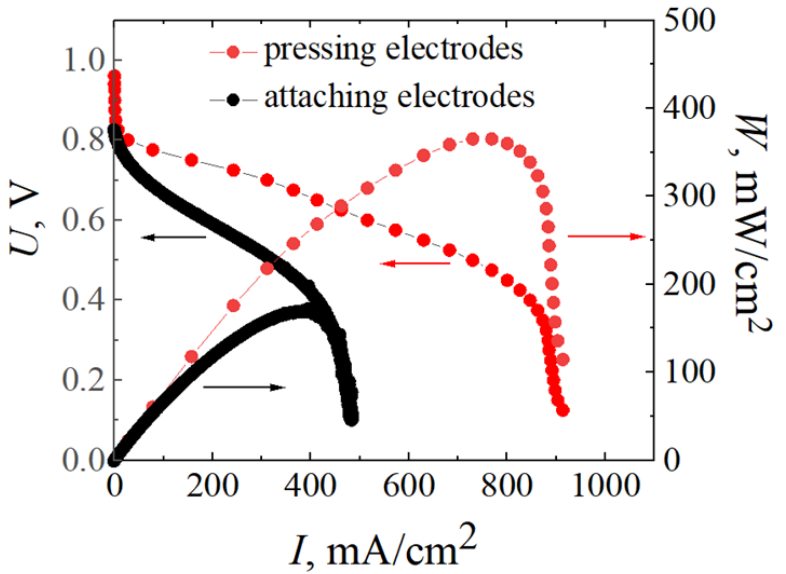
Figure 7. I-U and I-W dependencies of MEAs based on the co-PNIS 70 / 30 membrane with attaching (black points) and pressing (red points) electrodes.